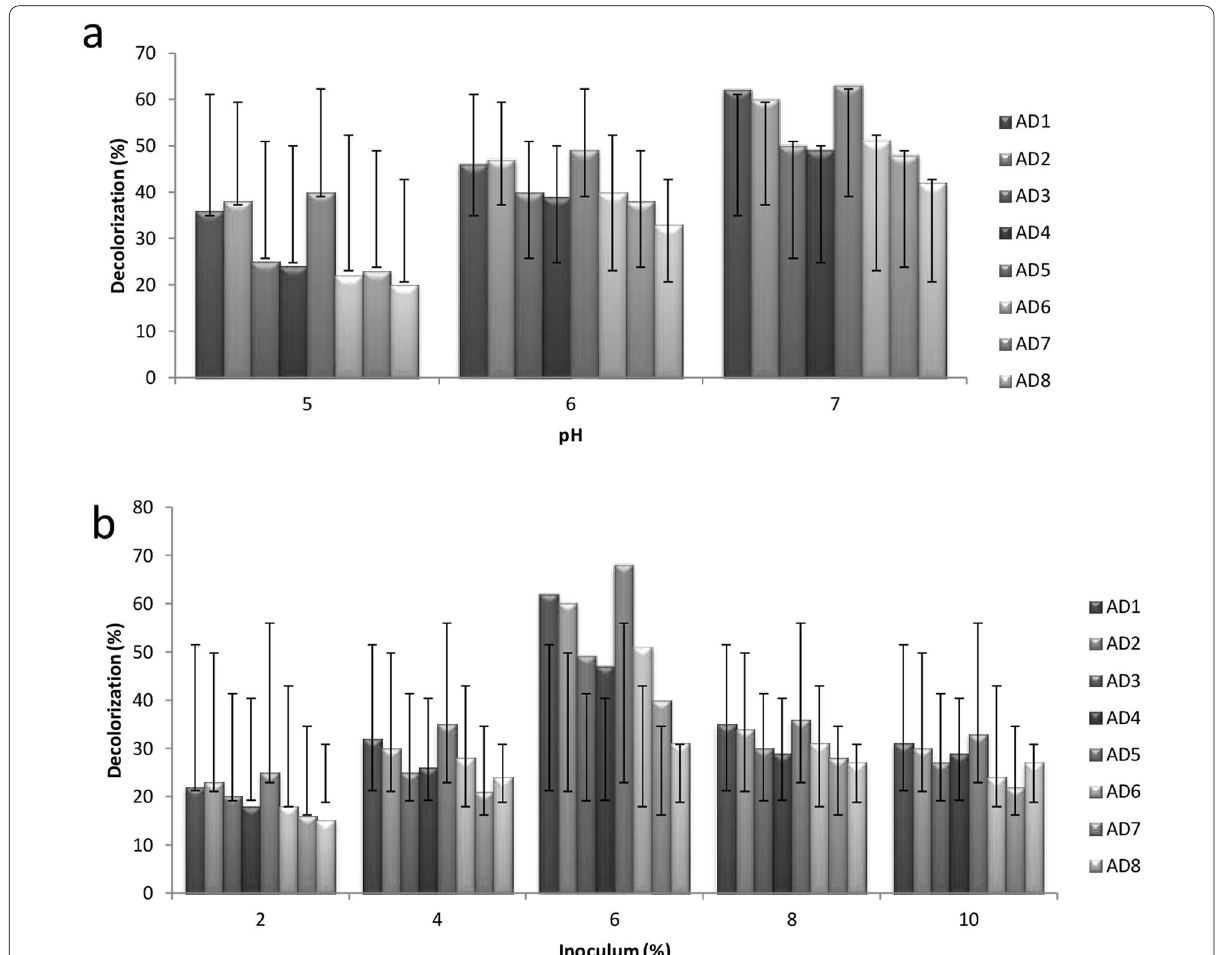
Fig. 1 Optimization studies for various parameters a pH b Inoculum c Temperature d Agitation